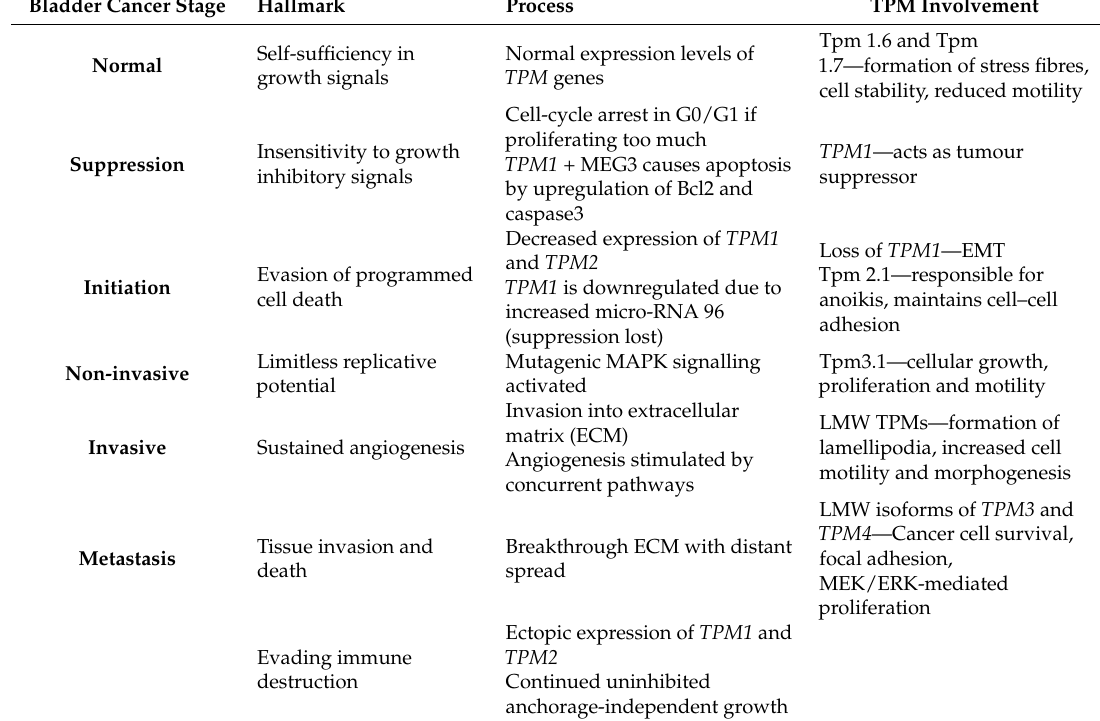
Table 2. TPM isoform usage in urothelial bladder carcinogenesis. EMT: epithelial–mesenchymal transition. Bladder Cancer